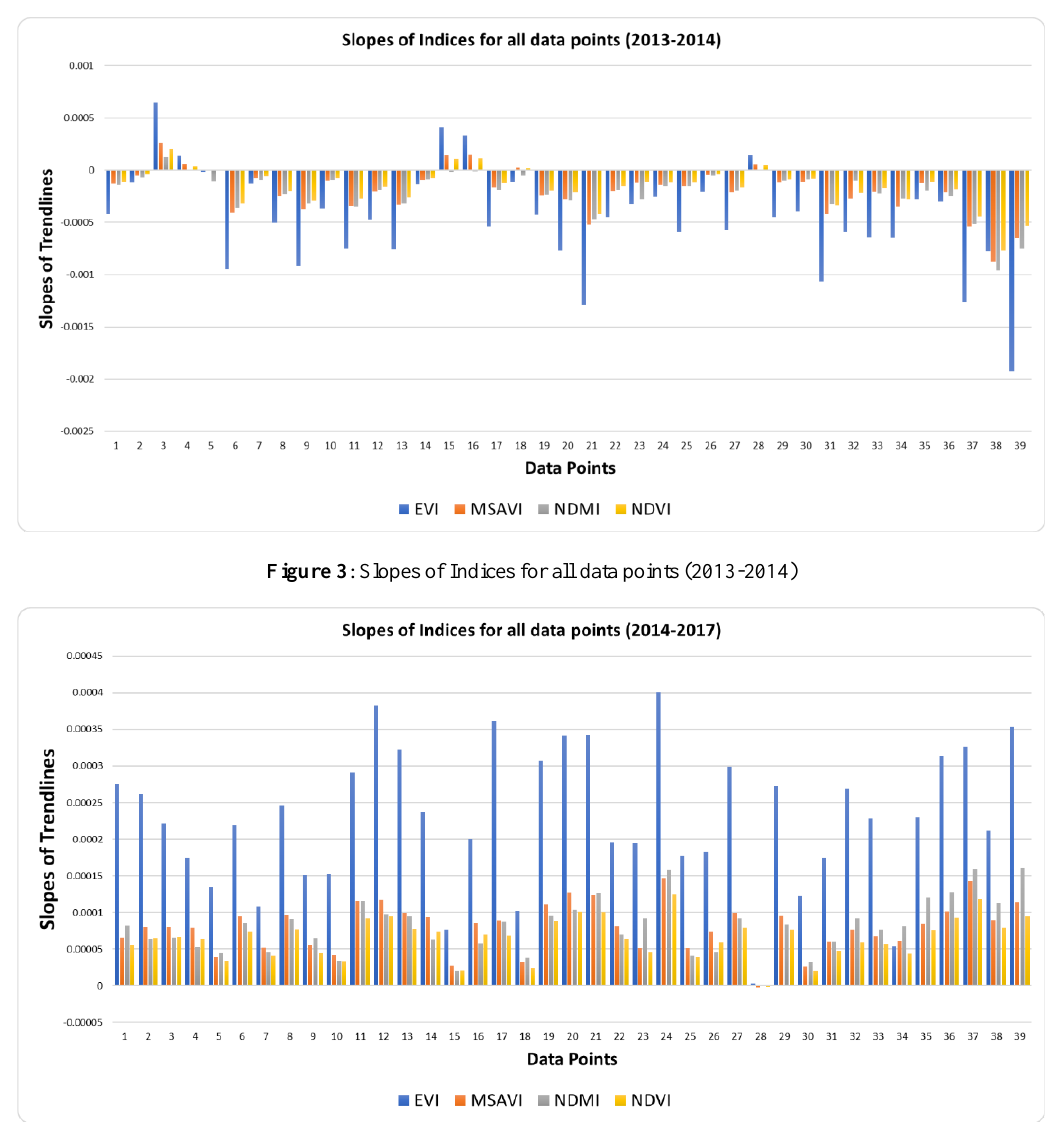
Figure 4: Slopes of Indices for all data points